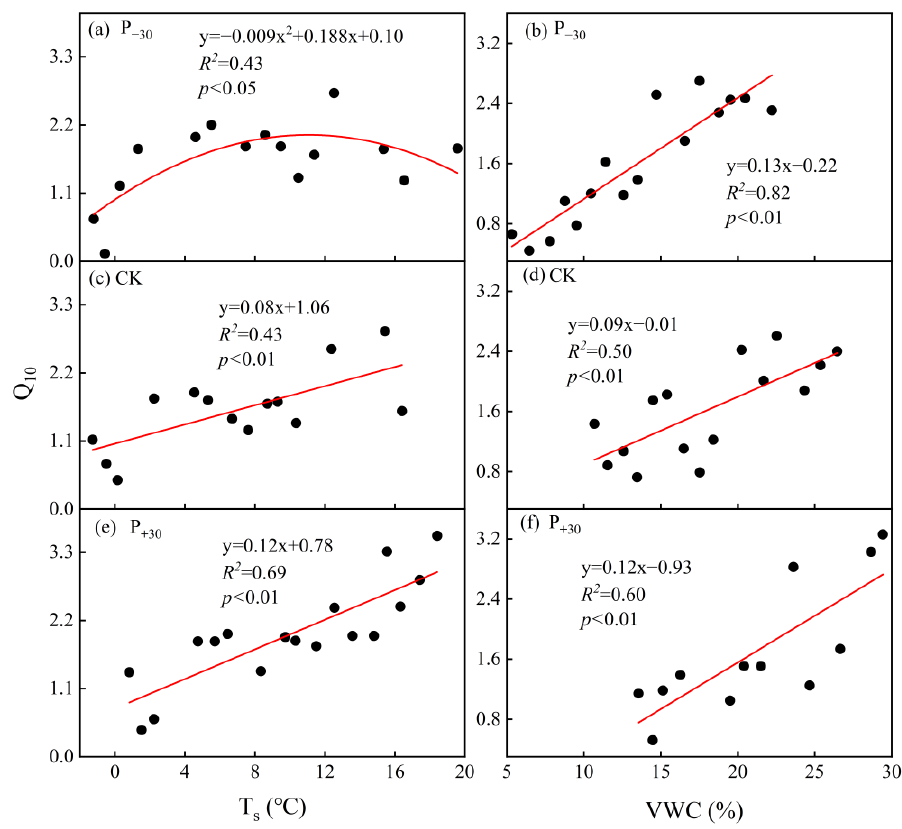
Figure 8. Relationships between seasonal soil temperature (T s ), soil volumetric water content (VWC), and Q 10 in the different precipitation treatments during the winter wheat whole growth period. The red lines indicates the significant relationship between Q 10 and T s (a, c and e) or VWC (b, d and f).